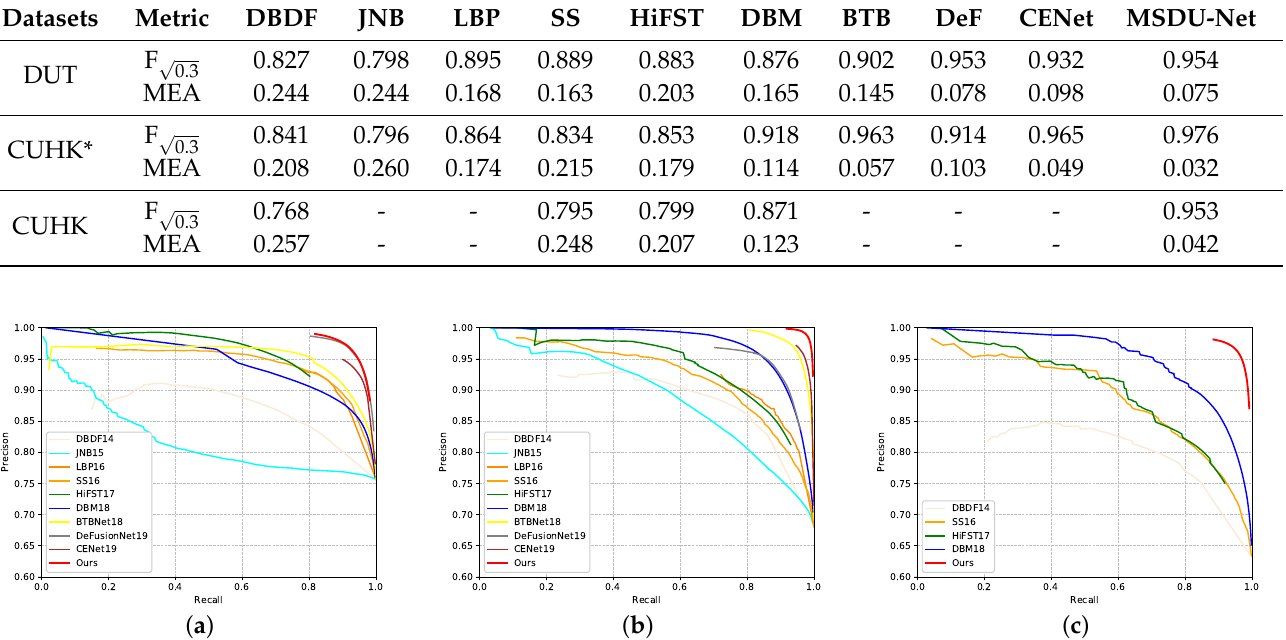
Figure 5. Comparison of the precision-recall curves of different methods on three test sets. The curves of our method are more than 95%. In particular, our method achieved an improvement of more than 0.2 progress in precision than the other method on the CUHK. ( a ) DUT test set; ( b ) CUHK ∗ test set(without motion blurred images); ( c ) CUHK test